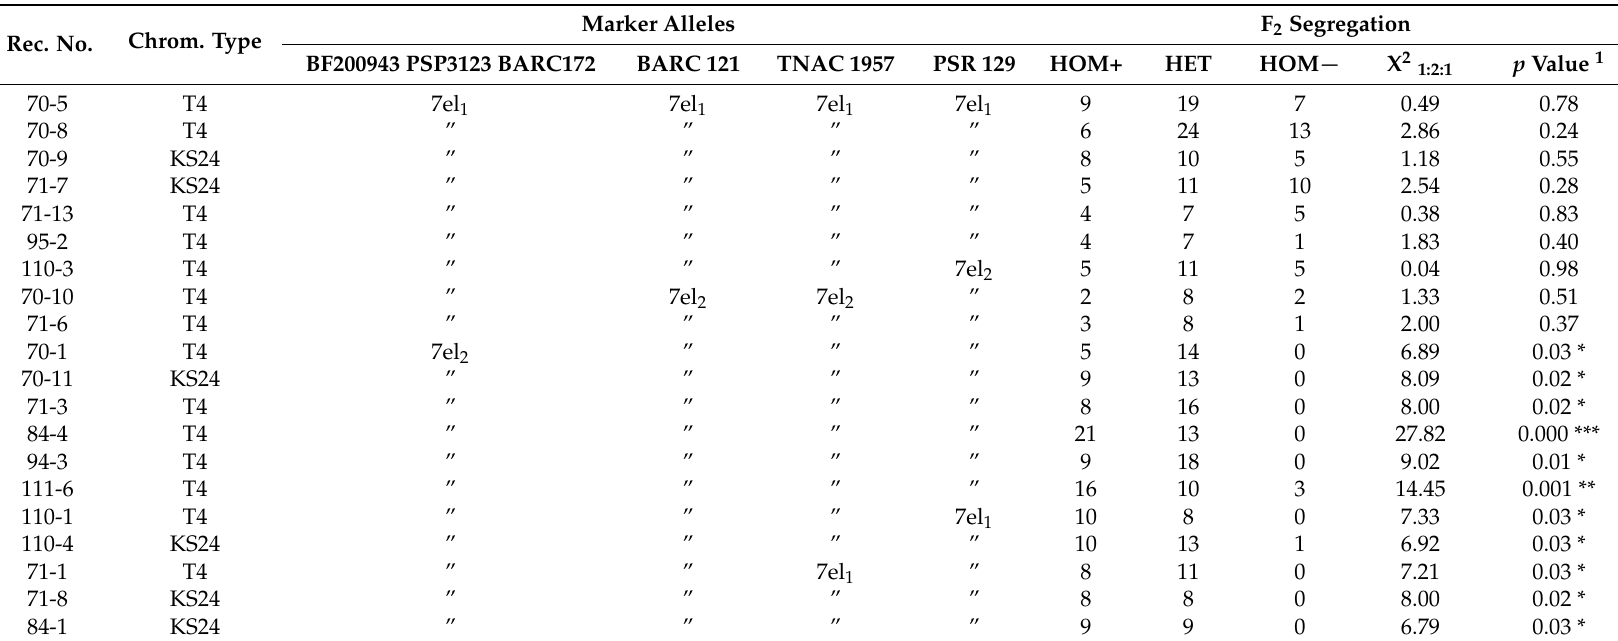
Table 3. Segregation in F 2 progenies from the KS24-1/T4/cv. Blasco cross and allele type of some of the markers used for progeny genotyping (see also Figure 5).